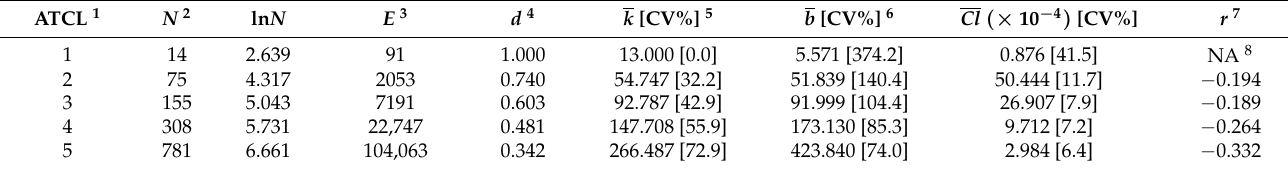
Figure 3. Drug prescription networks. Data on drug prescriptions were analysed to generate five drug prescription networks that correspond to the levels of the ATC classification system (ATCL1–ATCL5). Node diameter and edge thickness were proportional to the number of patients prescribed with the individual ATC i s and the pairs ATC i –ATC j within the ATC level 𝐿 , respectively. Nodes were coloured according to the 14 groups found at the first level of the ATC classification system. Table 1. Structural and statistical measures of drug prescription